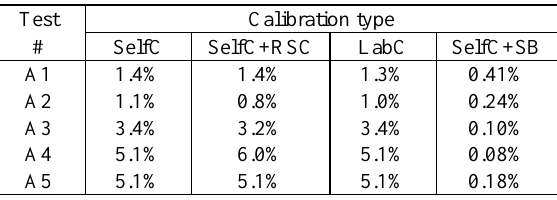
Table 1 . Relative errors in the length of verification distances of 15